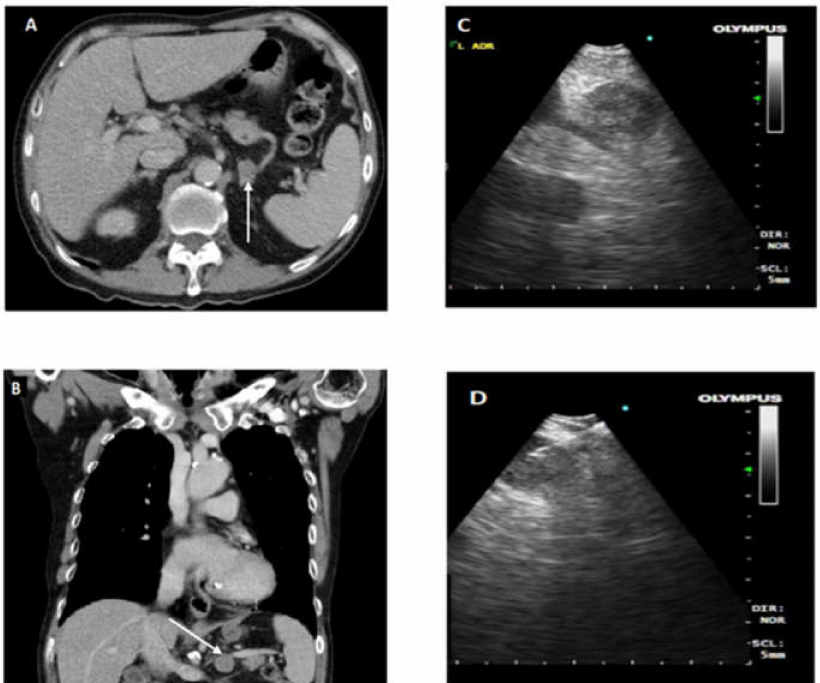
Figure 1. ( A,B ) CT axial and coronal sections, respectively. Arrowhead indicates enlarged left adrenal gland (LAG); ( C ) demonstrates EUS-B image of LAG; ( D ) illustrates EUS-B FNA of enlarged LAG with needle in target